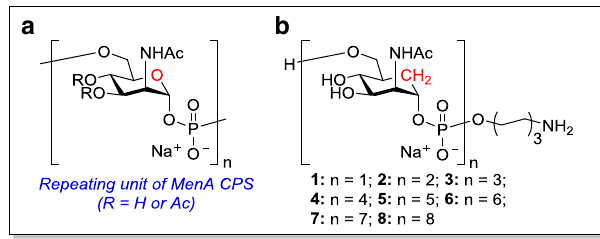
Fig. 1 Structure of MenA CPS and carbaMenA. a Native CPS repeating unit and b target MenA carba